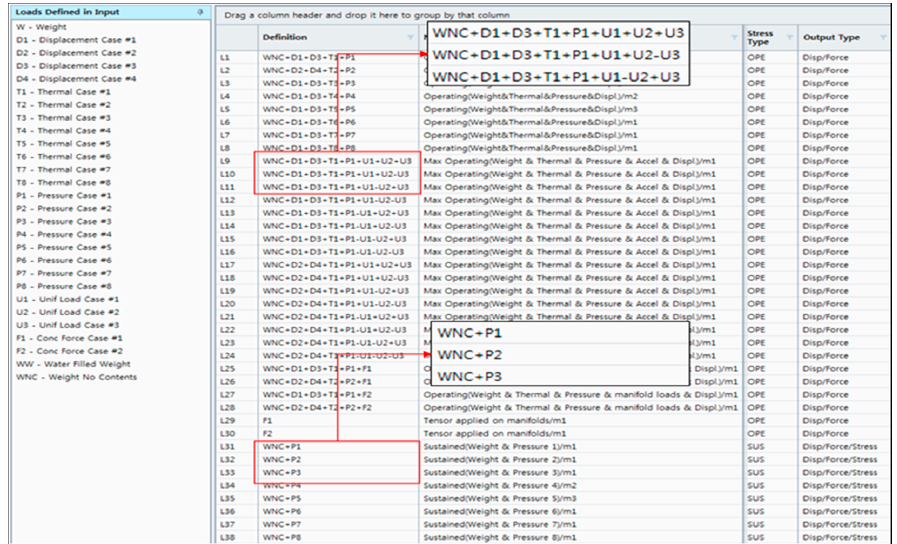
Figure 7. Combined load cases for stress analysis.